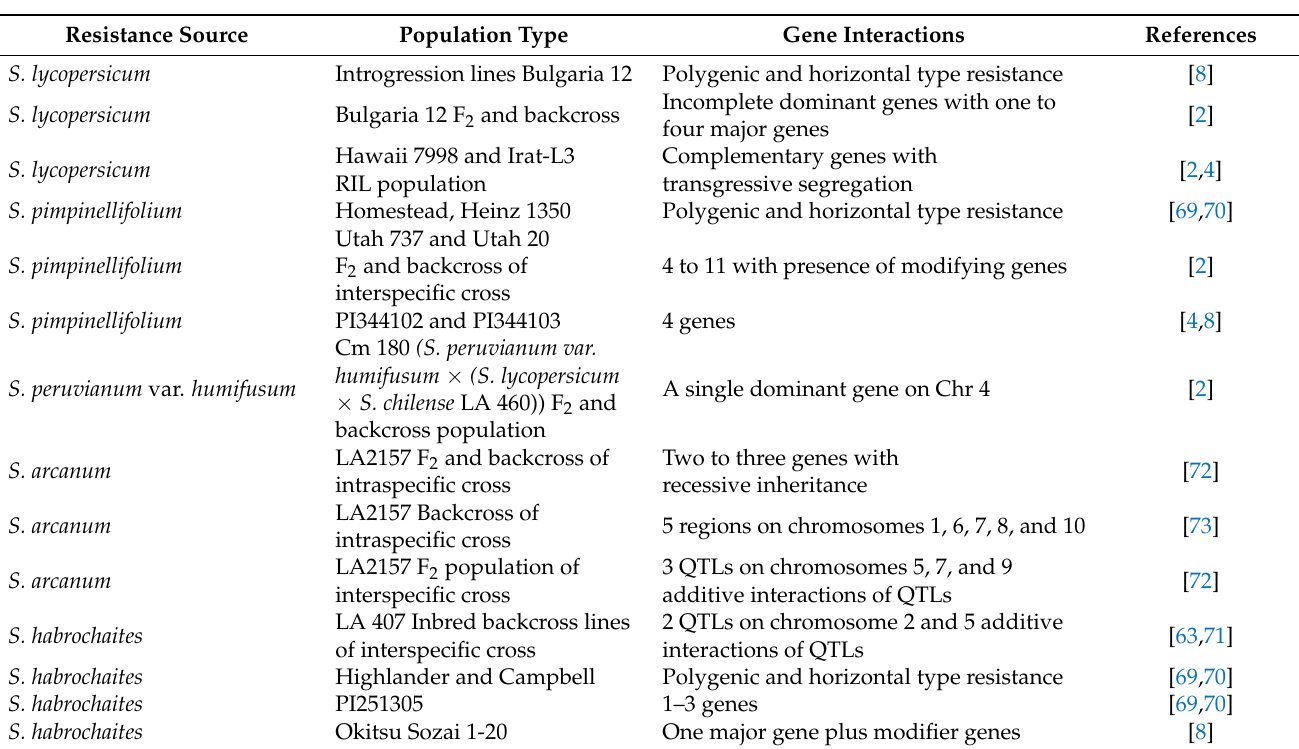
Table 2. Sources of resistance to Clavibacter michiganensis and their genetic interactions in Solanum